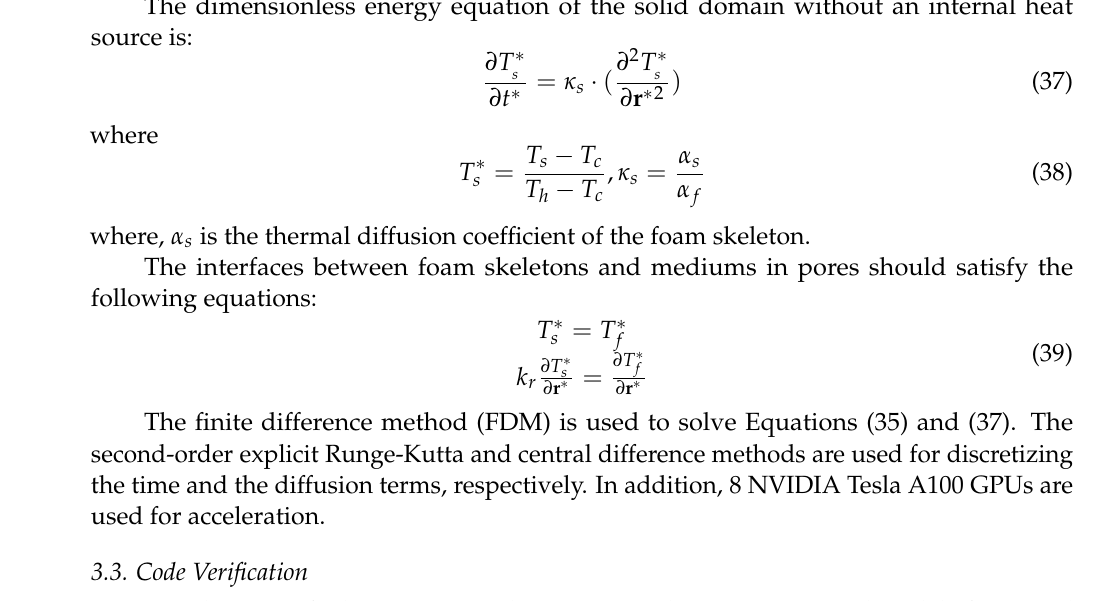
Figure 7. The variation of 2 / eff k k under different k at φ = 0.3 and 0.4.